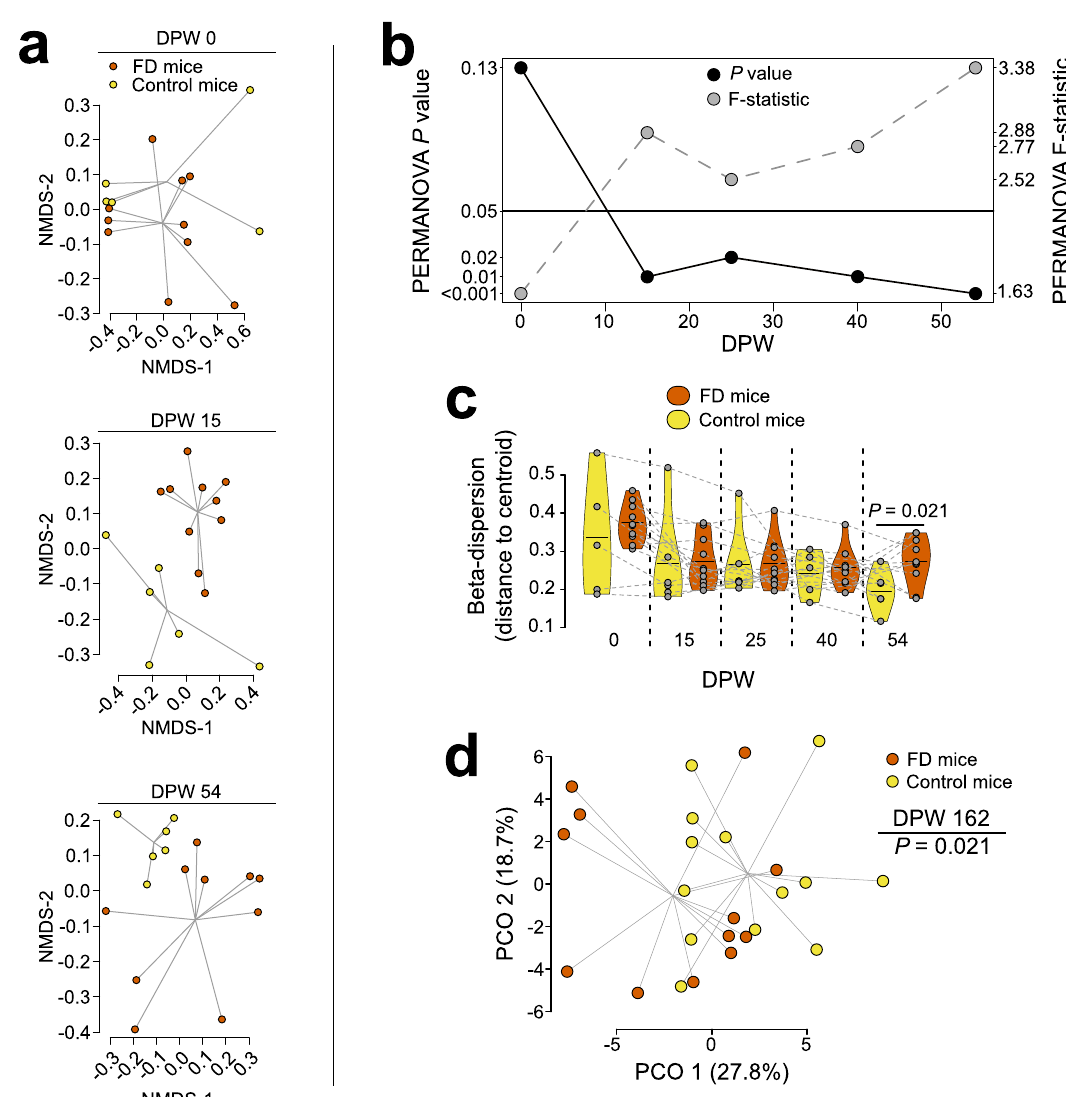
Fig. 3 | Neuron-speci fi c Elp1 deletion drives progressive microbiome and metabolome divergence in mice. a Nonmetric multidimensional scaling (NMDS) of 16S rRNA-based stool microbiome diversity of FD ( Tuba1a-cre + ; Elp1 loxp/loxp ) and control ( Tuba1a-cre − ; Elp1 +/loxp ) mice when housed separately by genotype (group colors same for all panels; DPW=days postweaning). b Progressive groupwise differences in microbiome beta-diversity (Bray-Curtis dissimilarity) and ( c ) dis- persion of beta-diversity (beta-dispersion) in FD mice (dotted lines connect indi- vidual mice, solid line in violin plots=mean). d Principal coordinates analysis of